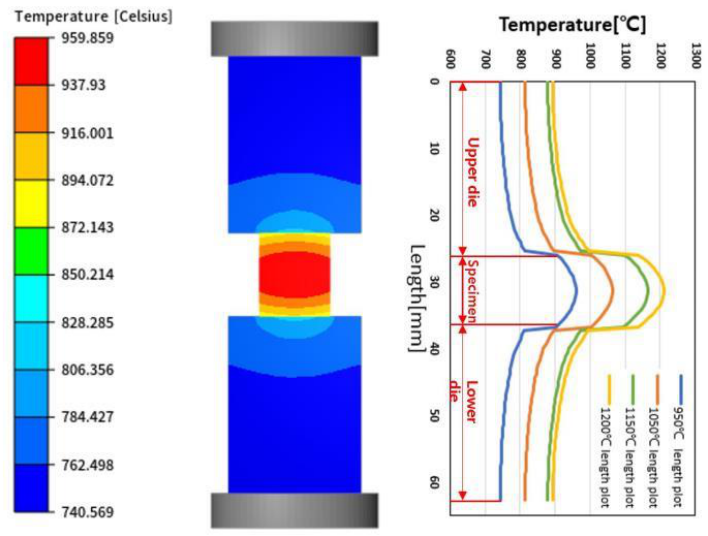
Figure 5. Temperature simulation results of the material and dies based on Joule heating analysis.